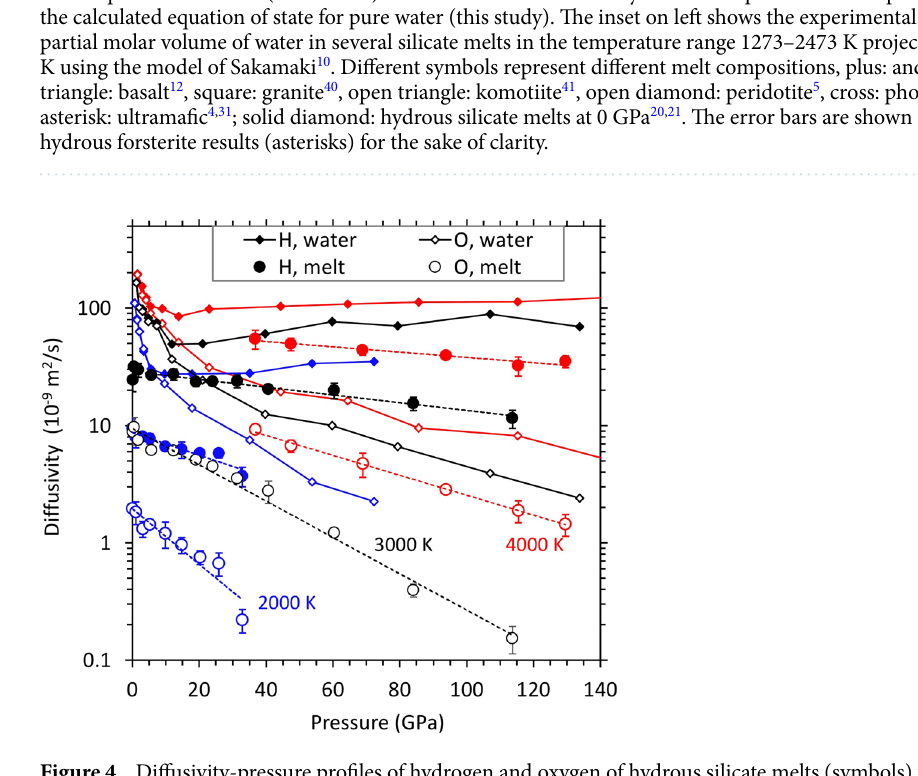
Figure 4. Diffusivity-pressure profiles of hydrogen and oxygen of hydrous silicate melts (symbols) taken as averages over five melt compositions (with the corresponding error bars shown) at three temperatures. Their Arrhenius trends are represented by straight dashed lines. The H and O diffusivity results of pure water are displayed, respectively, as solid and dashed curves (with small symbols). Color encodes temperature: blue 2000 K, black 3000 K, and red 4000